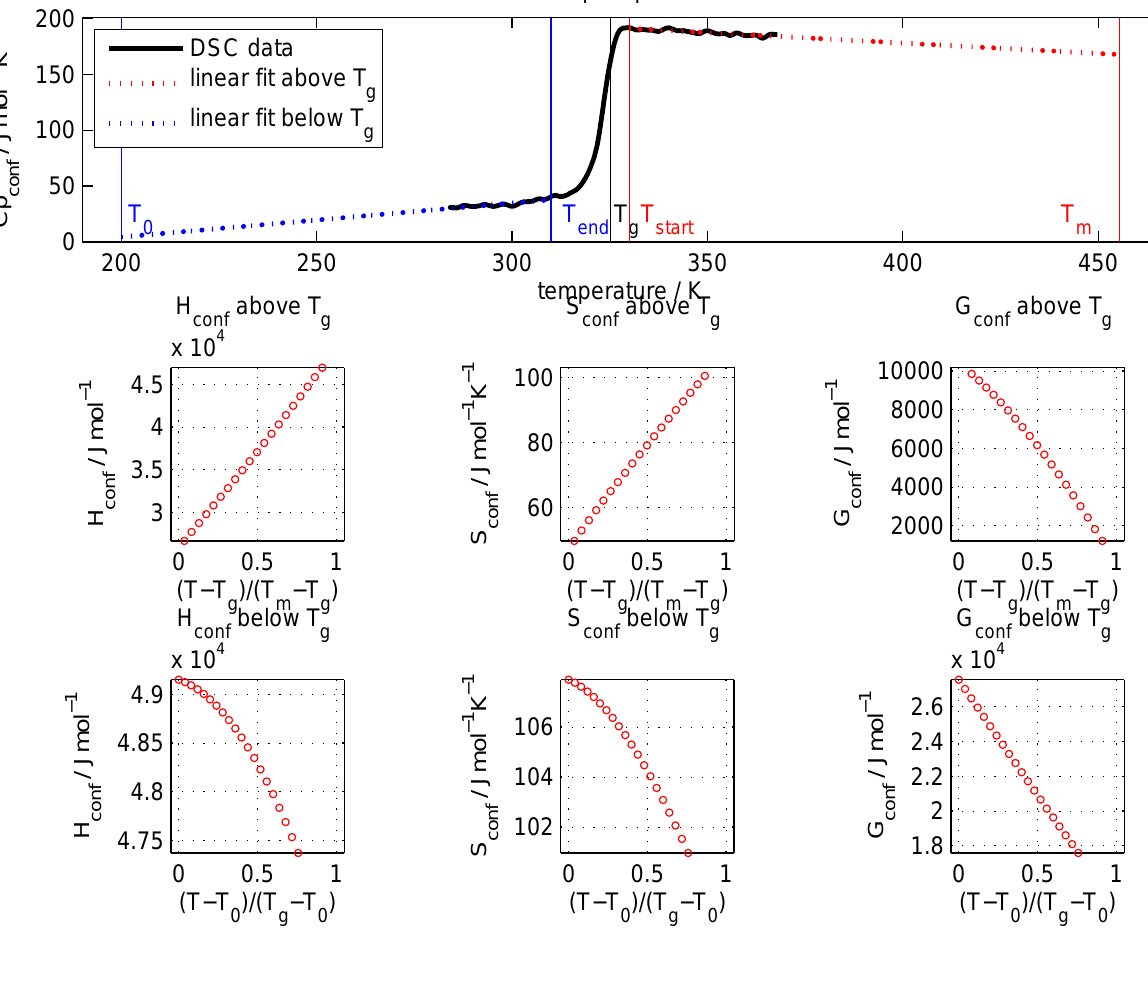
, T and the boundaries for the data fits g m , S and G above (middle row) and below conf conf conf